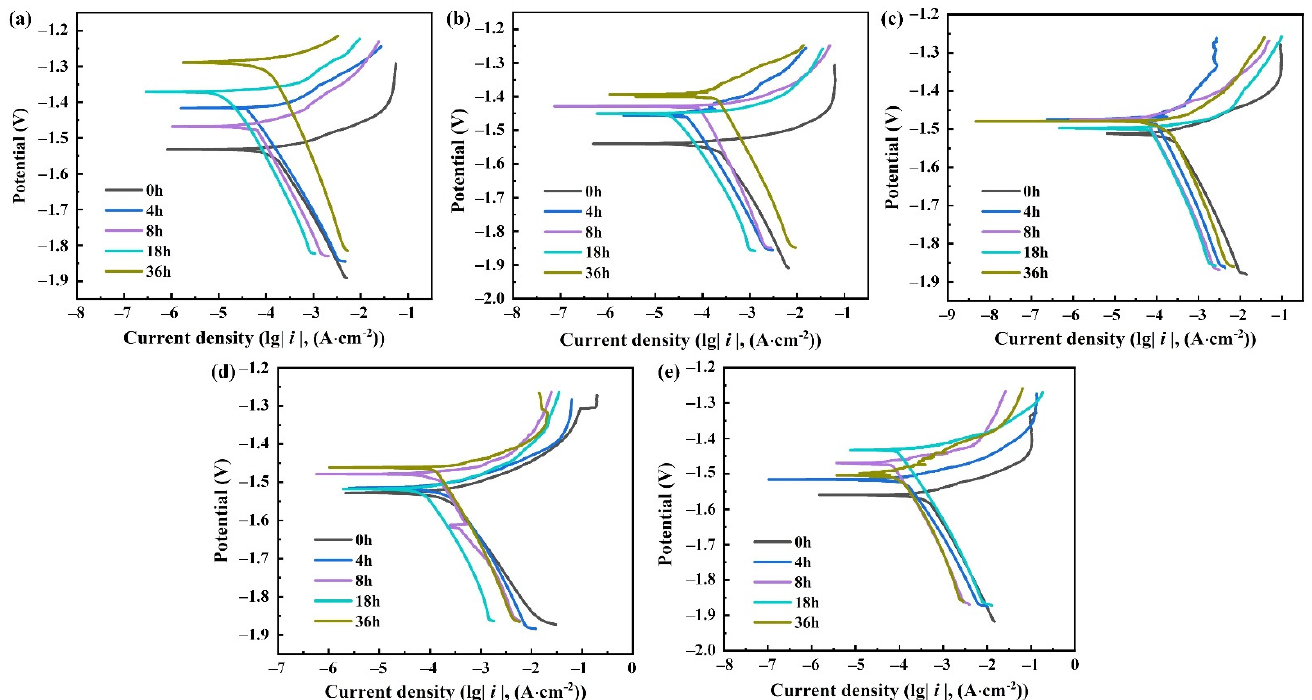
Figure 5. Polarization curves of ZK61M alloy in Cl − solutions with different concentrations: ( a ) 0.2 mol/L, ( b ) 0.4 mol/L, ( c ) 0.6 mol/L, ( d ) 0.8 mol/L and ( e ) 1.0 mol/L. ( b ) 0.4 mol/L, ( c ) 0.6 mol/L, ( d ) 0.8 mol/L and ( e ) 1.0 mol/L.